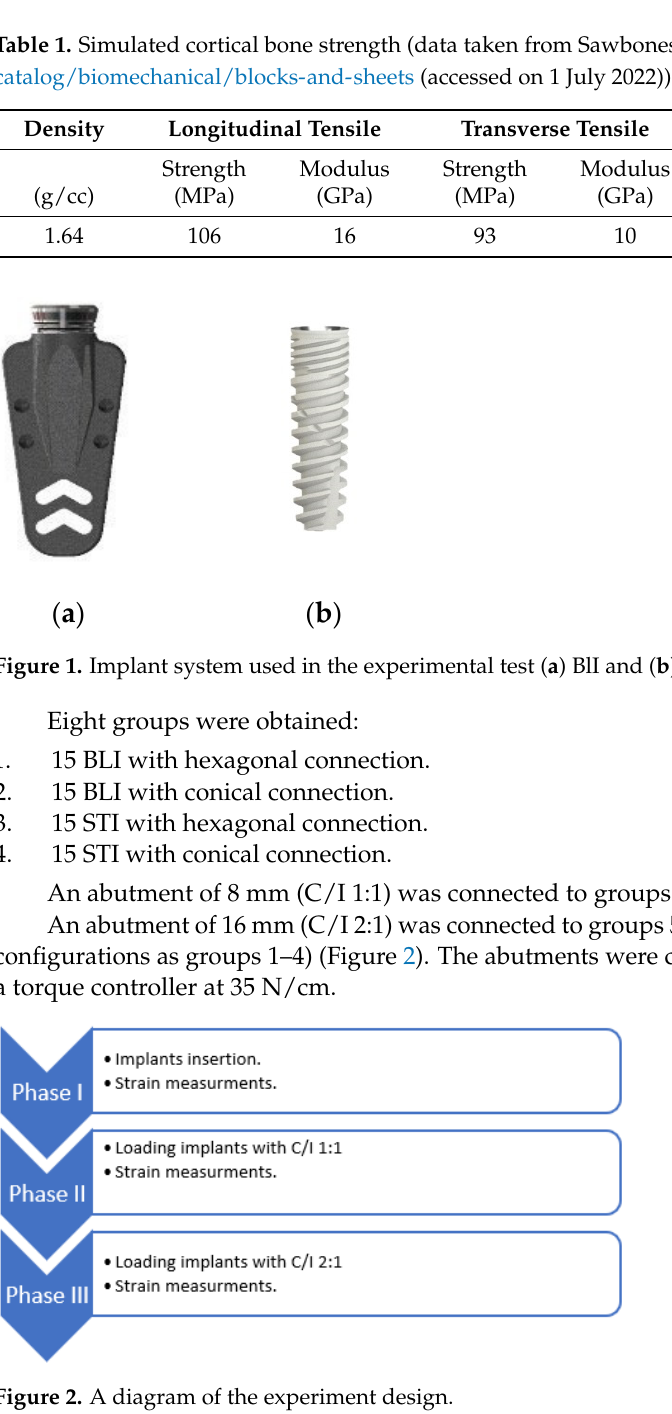
Figure 2. A diagram of the experiment design.